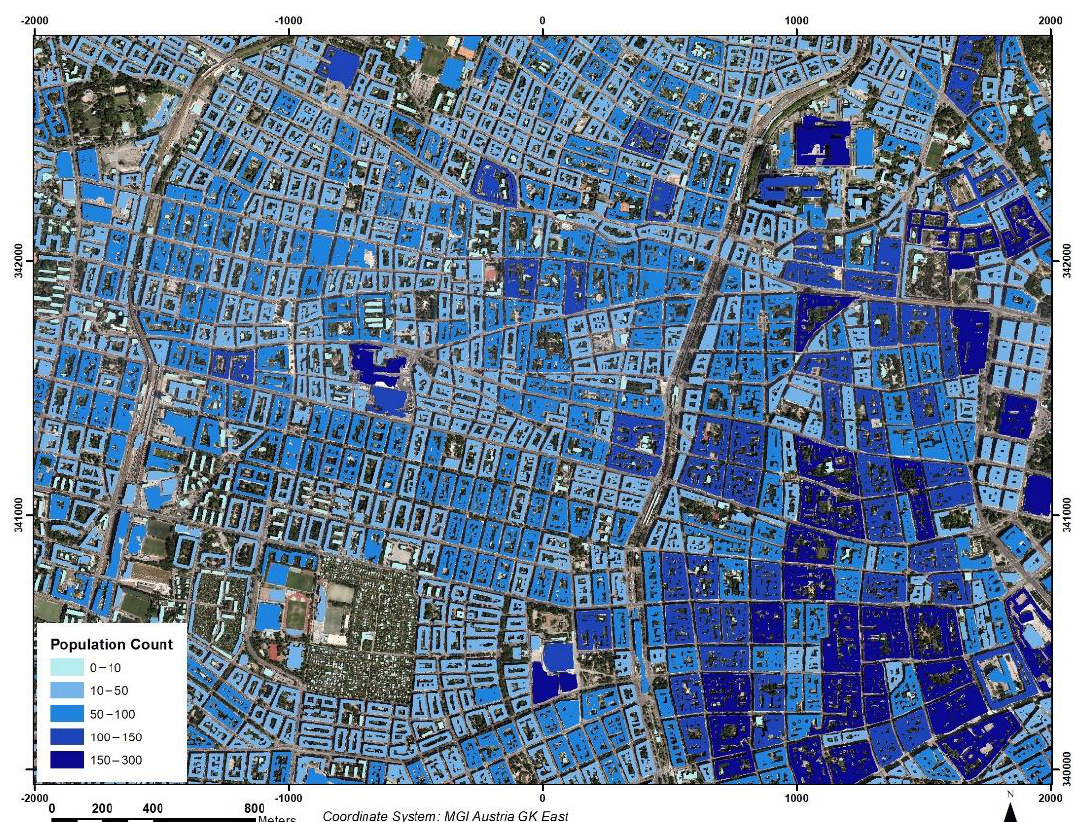
Figure 13. Maps created using the area and land use attributes of buildings in Austin: ( a ) Map showing calculated building area results in Austin; ( b ) Map showing added land use classes from OSM data to buildings in Austin.